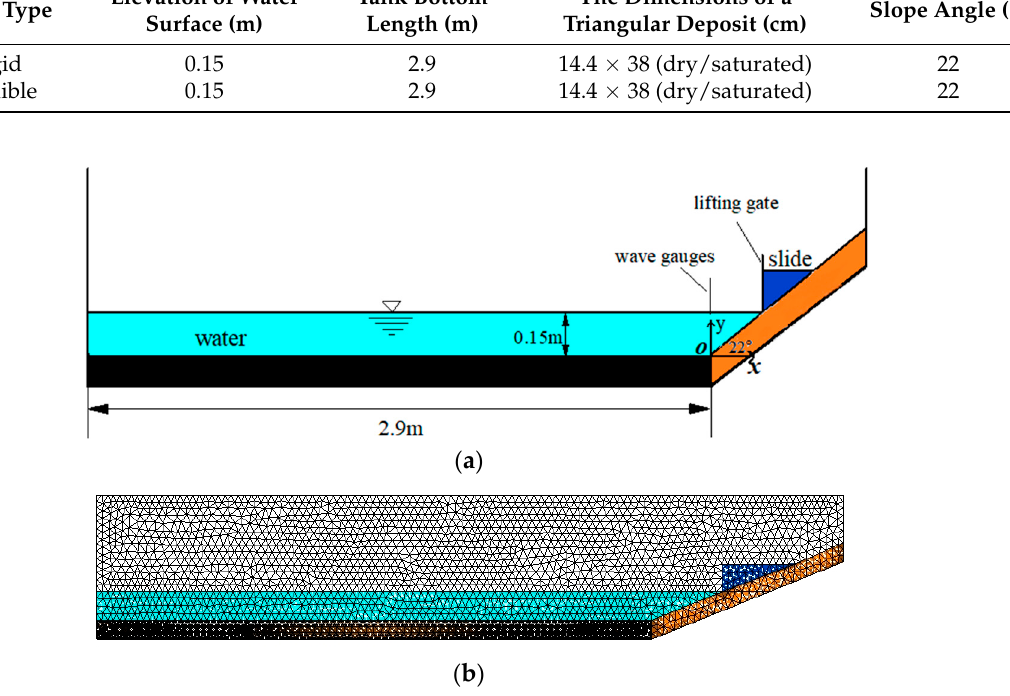
Figure 15. Schematic diagram of a computational model for water waves generated by dry particles sliding along a rigid slope: ( a ) Schematic of the initial model; ( b ) MPM discretization. Table 1. Main parameters of the model.